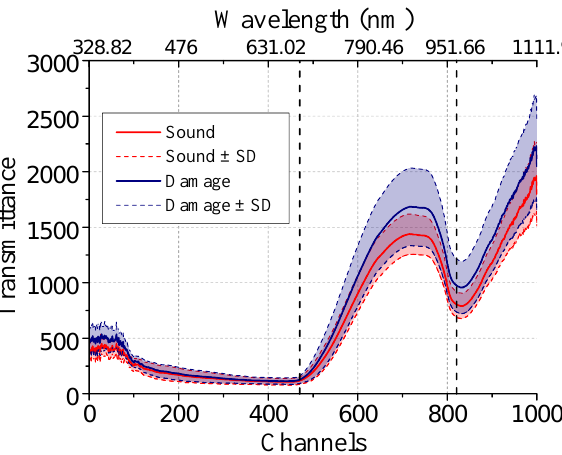
Figure 5. Average transmittance extracted from each channel in image